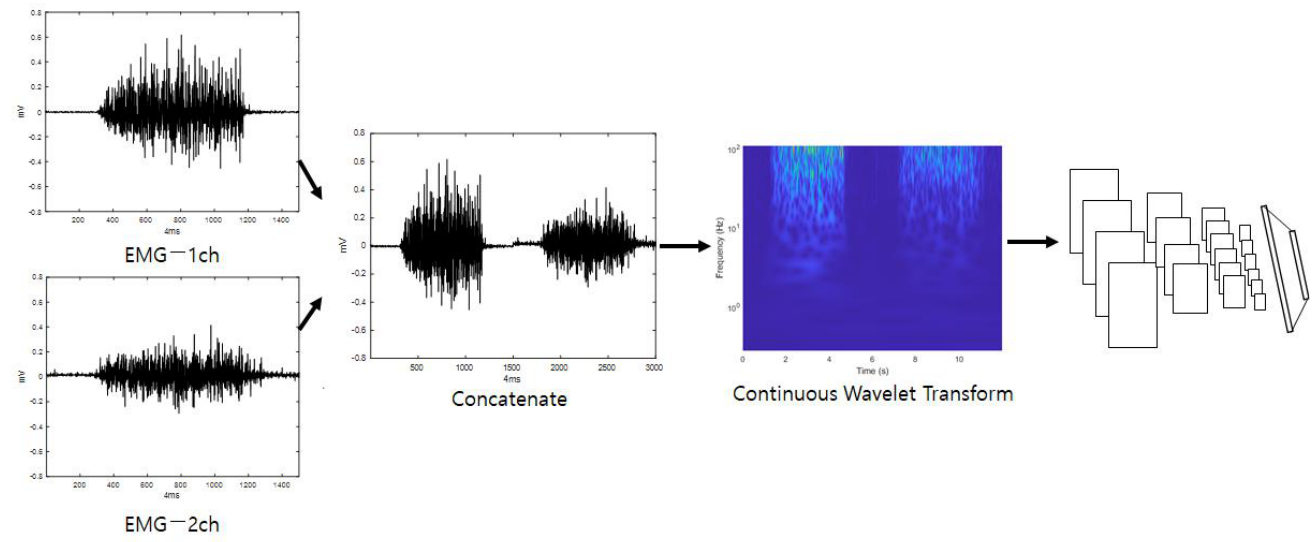
Figure 1. First stream’s detailed configuration